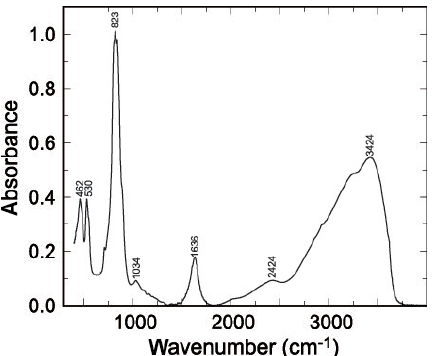
Figure 1. FTIR spectrum of pushcharovskite. Bands are marked with their positions in reciprocal centimetres.